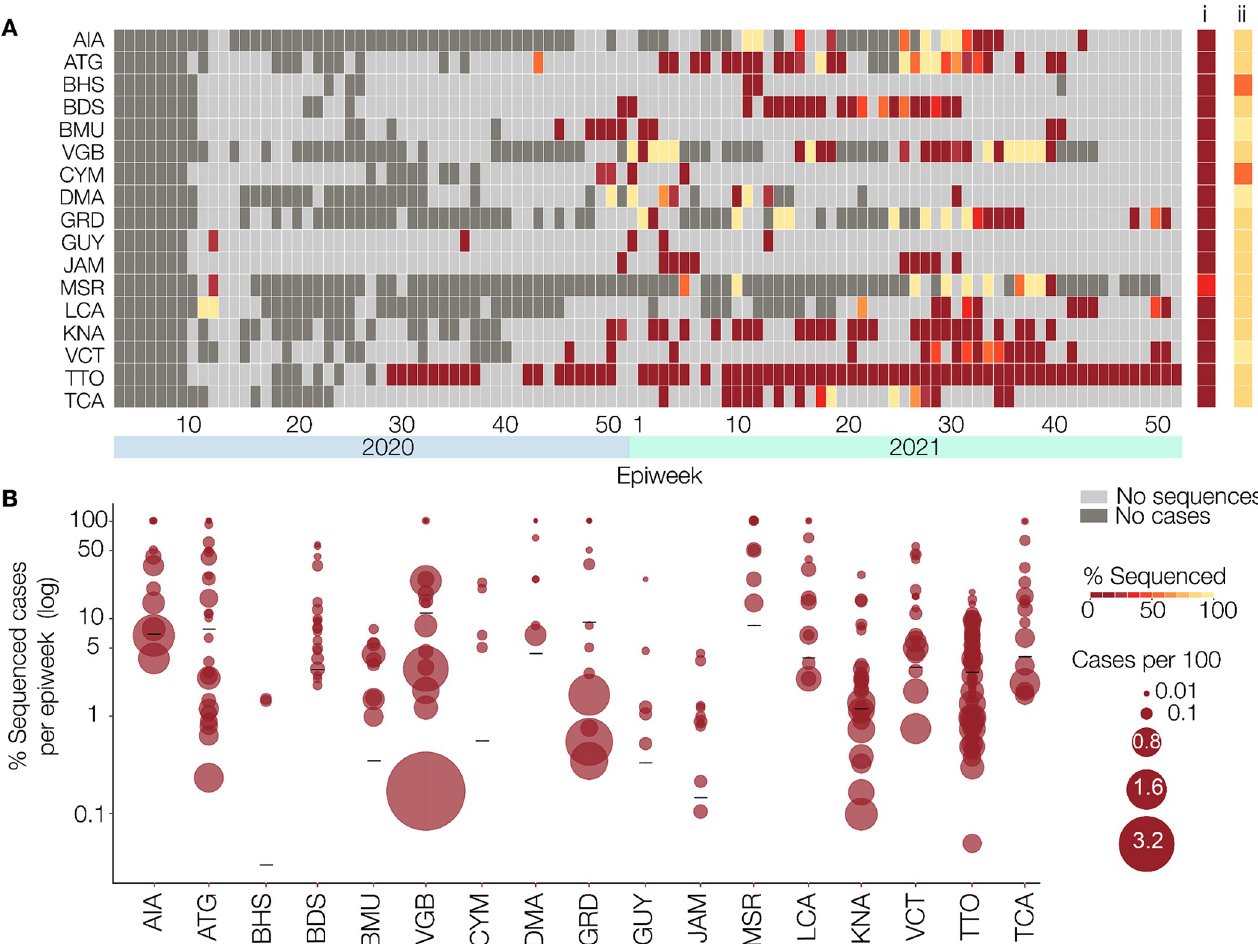
Fig 5. SARS-CoV-2 genomic surveillance by the COVID-19 IMPACT project. (A) Percentage of cases sequenced by the COVID-19 IMPACT laboratory per epidemiological week per CMS, between January 28 th 2020 and December 31 st 2021. For each CMS, the percentage of sequenced cases per epidemiological week is indicated by a coloured rectangle. Weeks during which there were no reported cases for that CMS are indicated in dark grey, and weeks in which there were cases reported for the CMS, but none were sequenced by the COVID-19 IMPACT laboratory are indicated in light grey. The overall percentage of cases sequenced by the COVID-19 IMPACT laboratory across the entire period is indicated for each CMS in column i. The percentage of samples received by the COVID-19 IMPACT laboratory that were successfully sequenced across the entire period is indicated for each CMS in column ii. The number of reported cases for each CMS is based on data available from The Johns Hopkins University Center for Systems Science and Engineering COVID-19 Data Repository. (B) Proportion of reported cases sequenced per CMS, between January 28 th 2020 and December 31 st 2021. Each circle indicates an epidemiological week during which at least one reported case for the respective CMS was sequenced and represents the percentage of sequenced cases for that week. Weeks where there were cases reported for the CMS but none were sequenced are not shown. The diameter of each circle represents the incidence (cases per 100/habitants) in that week for the respective CMS. The overall percentage of cases sequenced by the COVID-19 IMPACT laboratory for each CMS across the entire period is indicated by a black line. The number of reported cases for each CMS is based on data available from The Johns Hopkins University Center for Systems Science and Engineering COVID-19 Data Repository. CMS = CARPHA Member States. AIA = Anguilla. ATG = Antigua and Barbuda. BHS = Bahamas. BRB = Barbados. BMU = Bermuda. VGB = British Virgin Islands. CYM = Cayman Islands. DMA = Dominica. GRD = Grenada. GUY = Guyana. JAM = Jamaica. MSR = Montserrat. KNA = Saint Kitts and Nevis. LCA = Saint Lucia. VCT = Saint Vincent and the Grenadines. TTO = Trinidad and Tobago. TCA = Turks and Caicos Islands.